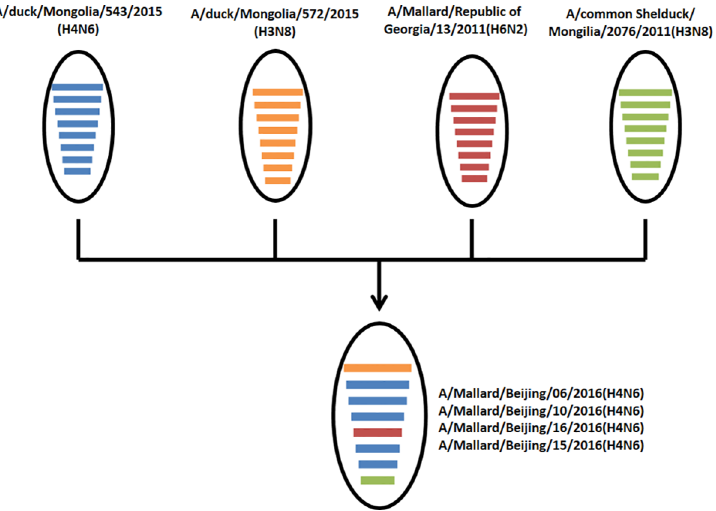
Fig 5. Schematic representation of putative genomic compositions of the four H4N6 AIVs isolated in this study and their possible parent viruses. The eight gene segments (from top to bottom) in each virus are PB2, PB1, PA, HA, NP, M, and NS. Each color represents a separate virus background. The simplified schematic illustrationis based on nucleotide-distancecomparisonand phylogenetic analysis.